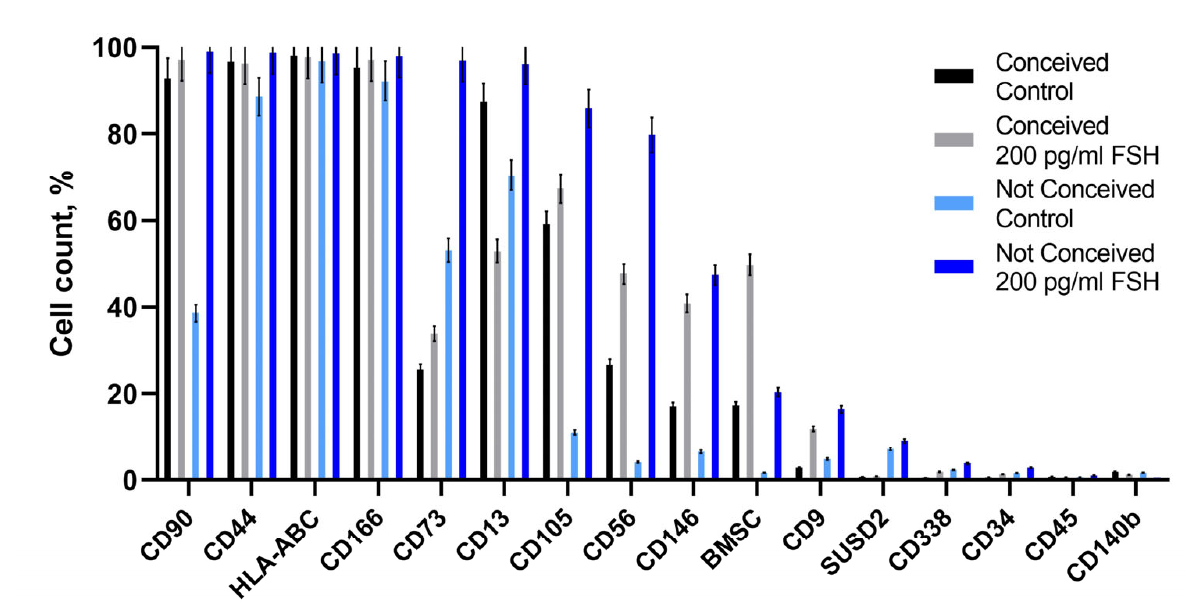
Figure 2. Analysis of cell surface markers of FF stromal cells. Control—untreated cells, FSH—cells after 30 days of culture in medium with 200 pg/mL FSH.